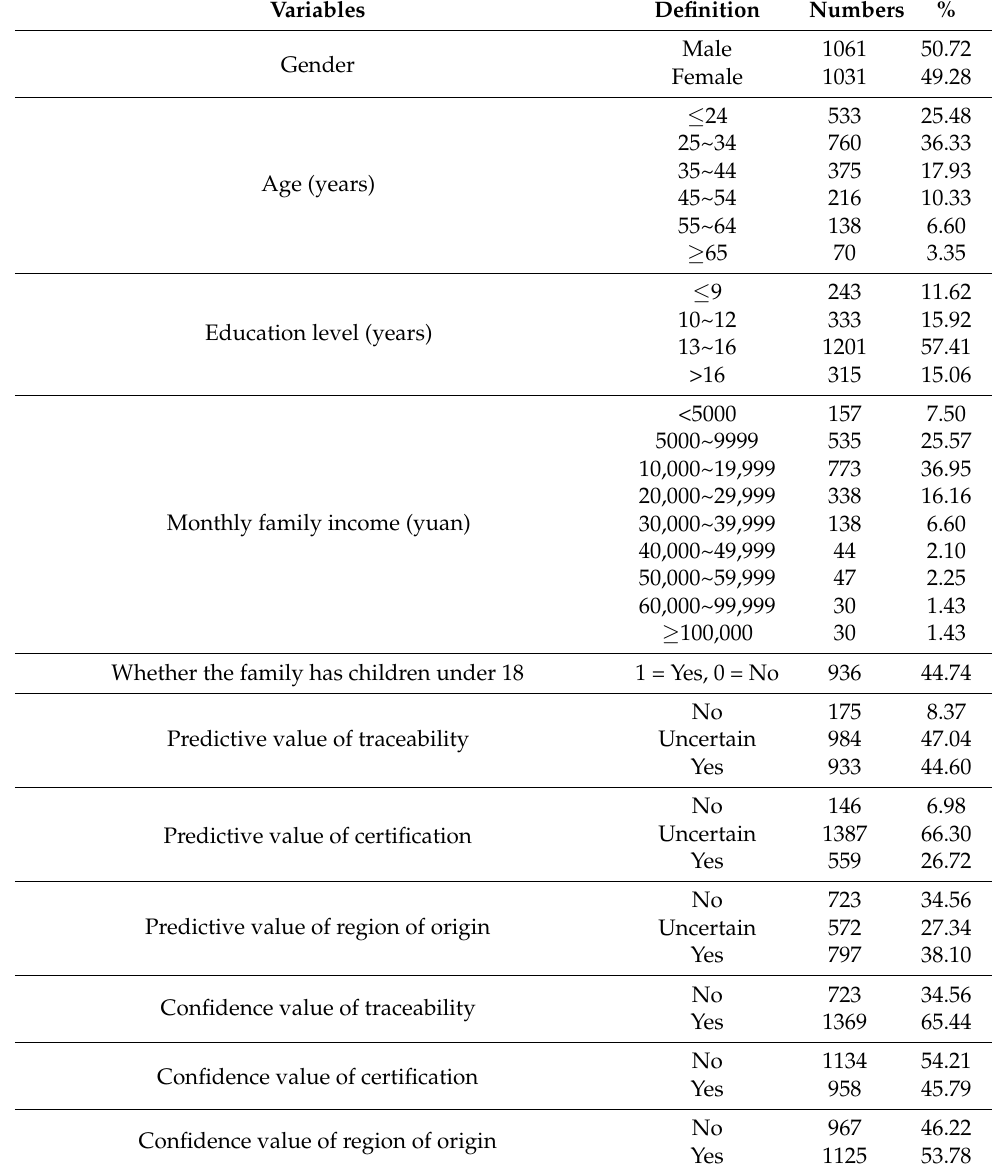
Table 2. Socio-demographic characteristics and perceived value of Fuji apple products’ information attribute of the sample.